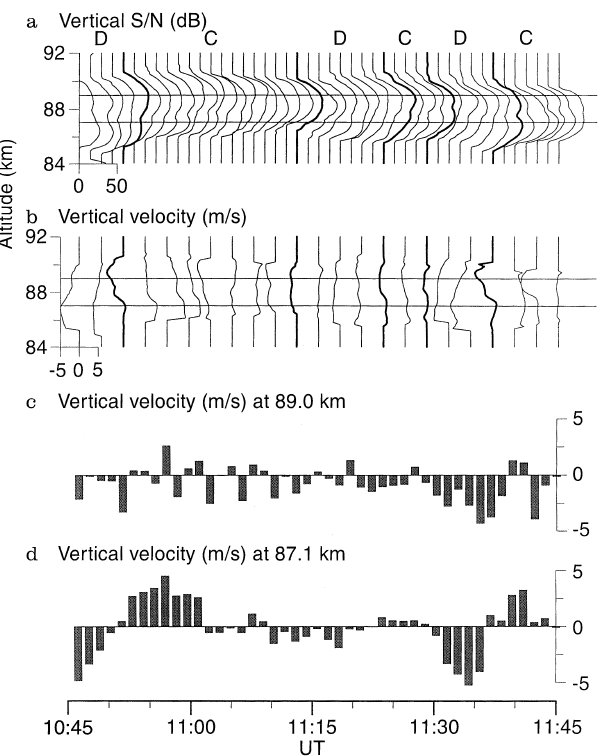
Fig. 6a–d. Altitude profiles of a the vertical S/N and b the vertical velocity on 21 June 1993. The bold profiles separate periods in which the vertical velocity of the upper section is predominantly more positive than that of the lower section, marked D , and periods for which the reverse is true, marked C . Also shown are the variations in vertical velocity at altitudes of c 89.0 km and d 87.1 km, indicated by the horizontal lines in the upper and lower sections of the echoes shown in a and b